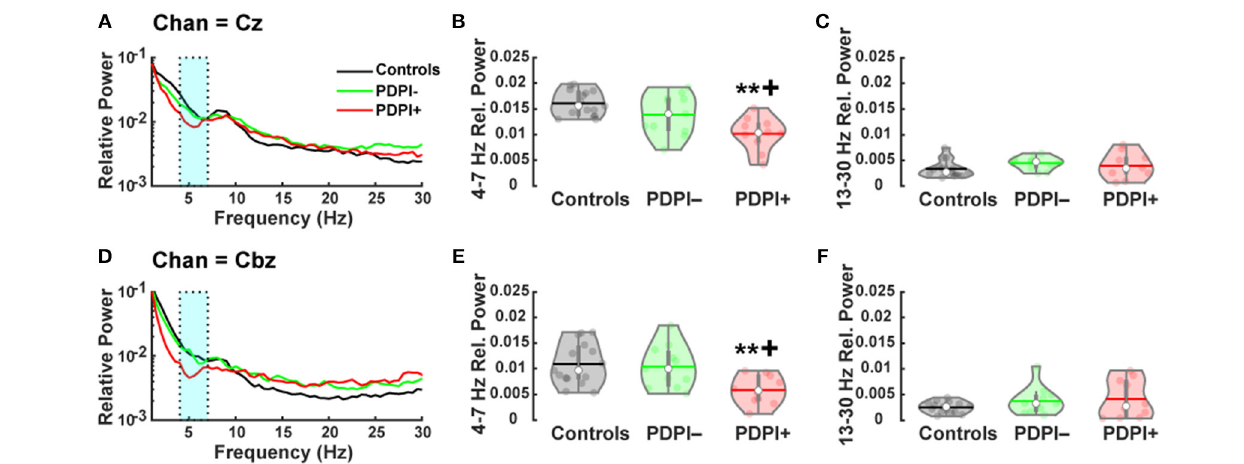
FIGURE 2 | Parkinson’s disease patients with postural instability (PDPI + ) demonstrate lower mid-frontal and mid-cerebellar theta-band power during a postural control task. (A) Spectral power distribution for the mid-frontal Cz electrode. (B) PDPI + exhibit decreased mid-frontal theta-band (4–7Hz) power compared to PDPI– and healthy controls. (C) No difference is observed in the beta-band (13–30Hz) over the mid-frontal Cz electrode. (D) Spectral power distribution for the mid-cerebellar Cbz electrode. (E) PDPI + exhibit decreased mid-cerebellar theta-band power compared to PDPI– and healthy controls. (F) No difference is observed in the beta-band over the mid-cerebellar Cbz electrode. (A–D) Cyan box indicates the theta-band. ** p ≤ 0.01 vs. controls, + p < 0.05 vs. PDPI–. The horizontal lines and white circles in the violin plots represent the mean and median values, respectively.